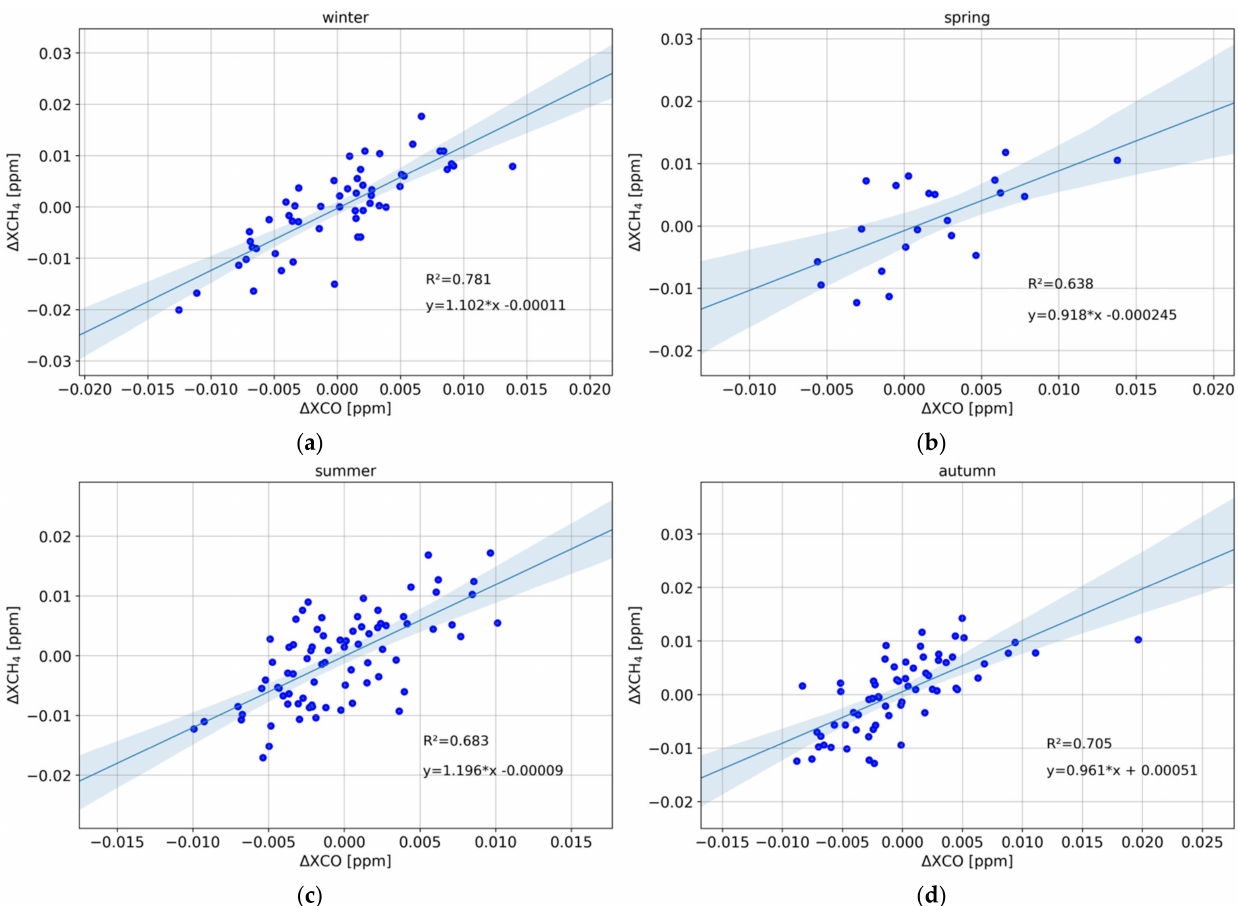
Figure 8. Correlation between collocated ∆ XCO and ∆ XCH 4 for winter ( a ), spring ( b ), summer ( c ) and autumn ( d ), and the resulting linear correlation line. The confidence interval is shown in the faded light-blue